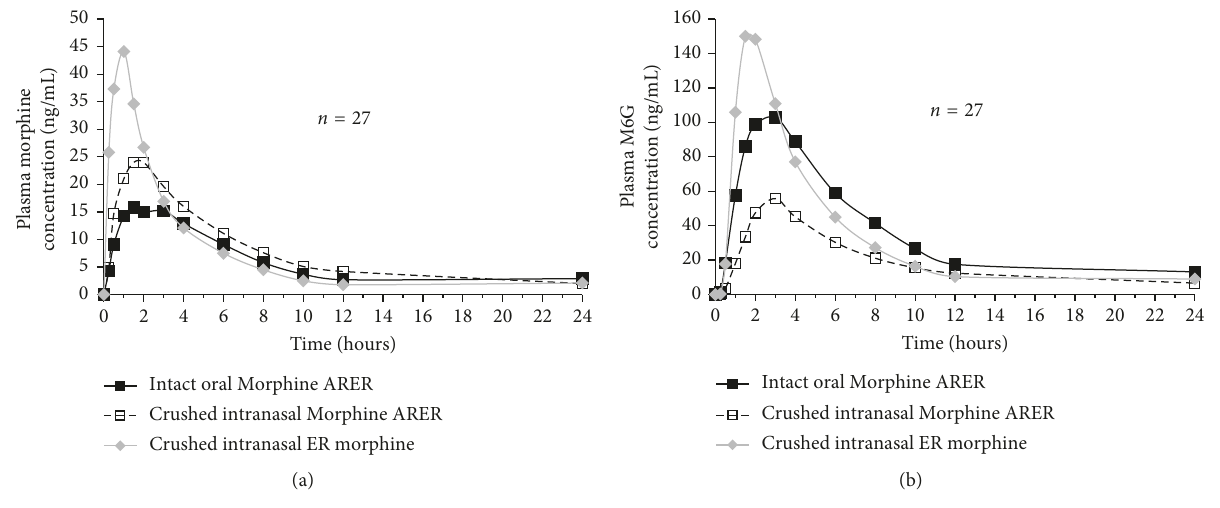
Figure 1: Mean plasma concentration-time profile of (a) morphine and (b) M6G by treatment (PK population, n Table 1: Pharmacokinetic parameters for morphine after administration of crushed intranasal Morphine ARER, crushed intranasal ER morphine, or intact oral Morphine ARER (PK population, n Parameter